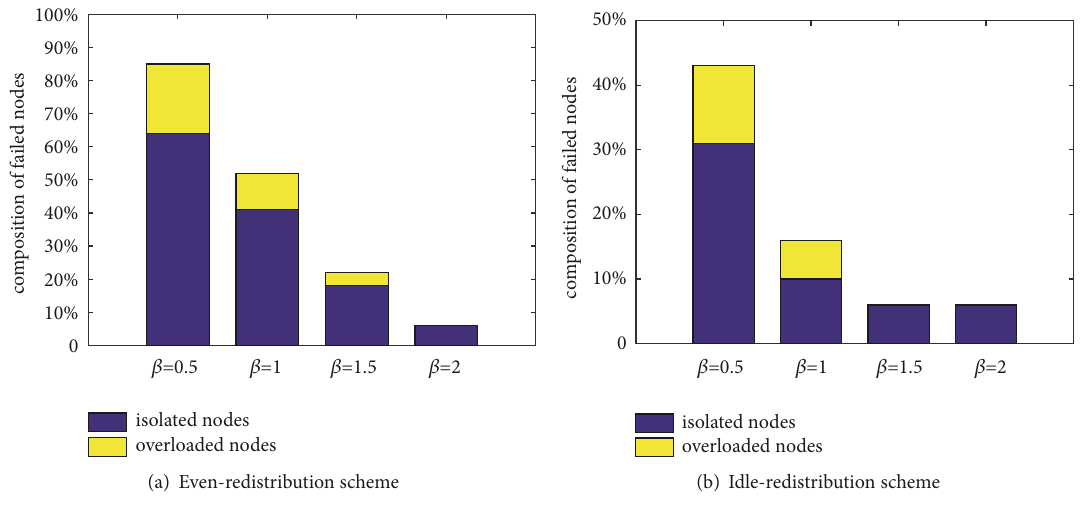
Figure 9: Composition of failed nodes with varying 𝛽 ( 𝛼 = 1 , Δ𝑡 = ∞ ).